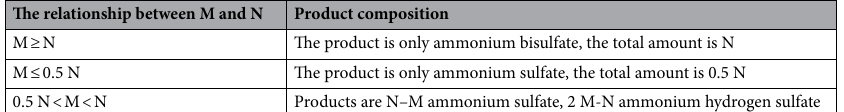
Table1. Composition analysis method of ammonium sulfate and ammonium